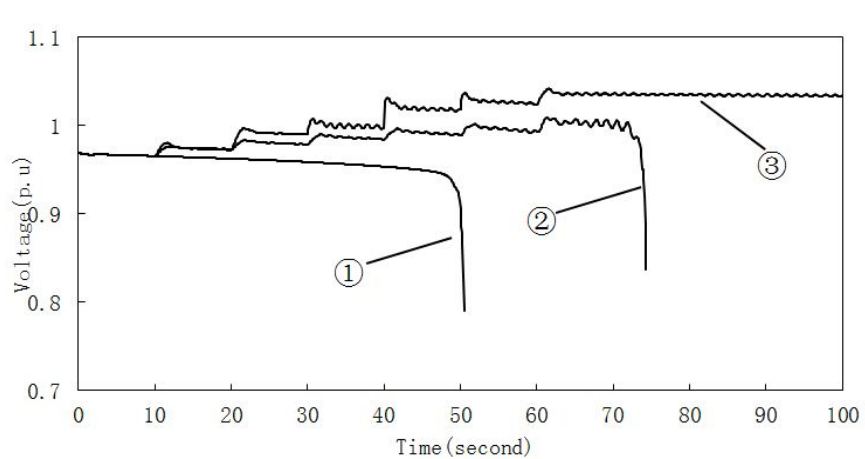
Figure 6. Voltage curve of generator